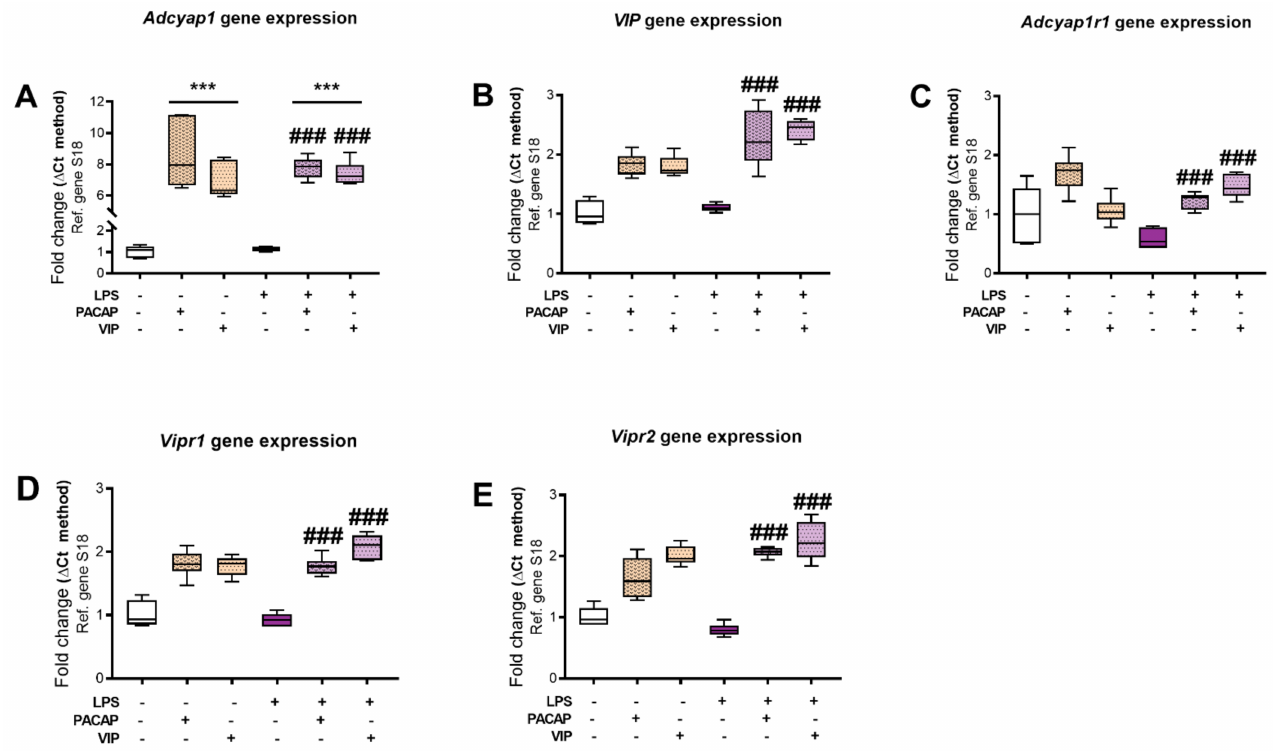
Figure 3. PACAP, VIP and receptors gene expression after treatment with LPS in the presence (or not) of exogenous PACAP or VIP. Real-time qPCR analyses of ( A ) Adcyap1 , ( B ) Vip , ( C ) Adcyap1r1 , ( D ) Vipr1 and ( E ) Vipr2 mRNA levels in BV2 cells that were either left untreated or treated with 100 nM PACAP, 100 nM VIP, 1 µ g/mL LPS alone or in the presence of PACAP or VIP after 24 h. Relative changes in mRNA levels were determined using the Delta-CT method and normalized to the ribosomal protein subunit S18, here used as the housekeeping gene. Data represent the mean of 3–6 biological replicates for each group. Results are expressed as mean ± SEM. *** p < 0.001 vs. control, ### p < 0.001 vs. LPS only as determined by one-way ANOVA followed by Tukey post hoc test. ( Gene : protein acronyms): Adcyap1 : PACAP, Vip : VIP, Adcyap1r1 : PAC1 receptor, Vipr1 : VPAC1 receptor, Vipr2 : VPAC2 receptor, S18 : ribosomal protein